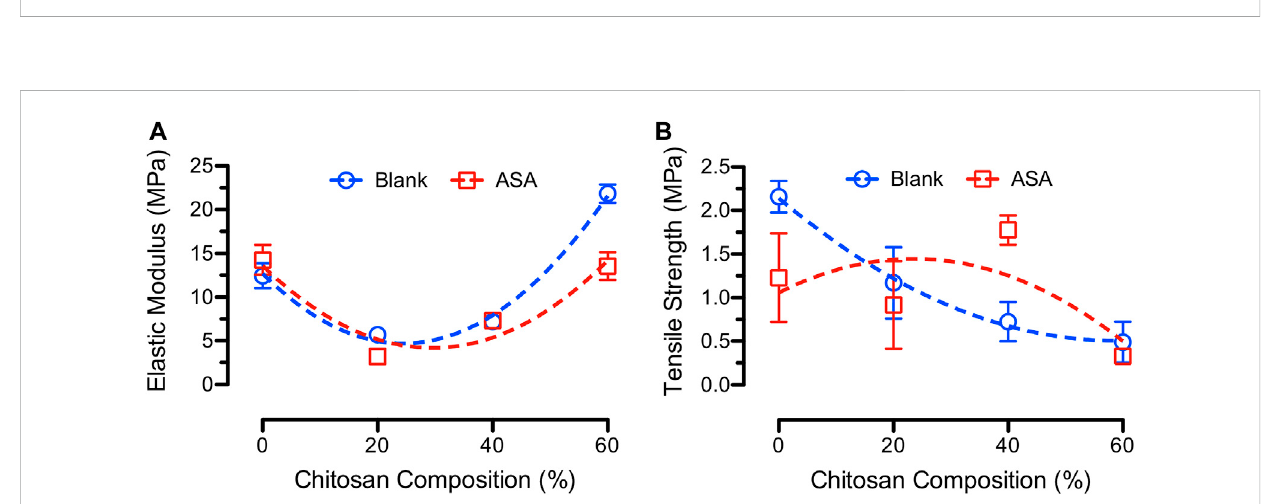
FIGURE 5 (A) Average elastic moduli and (B) average tensile strength of blank (blue) and ASA-loaded (red) PCL/CS blend fi bers at various CS